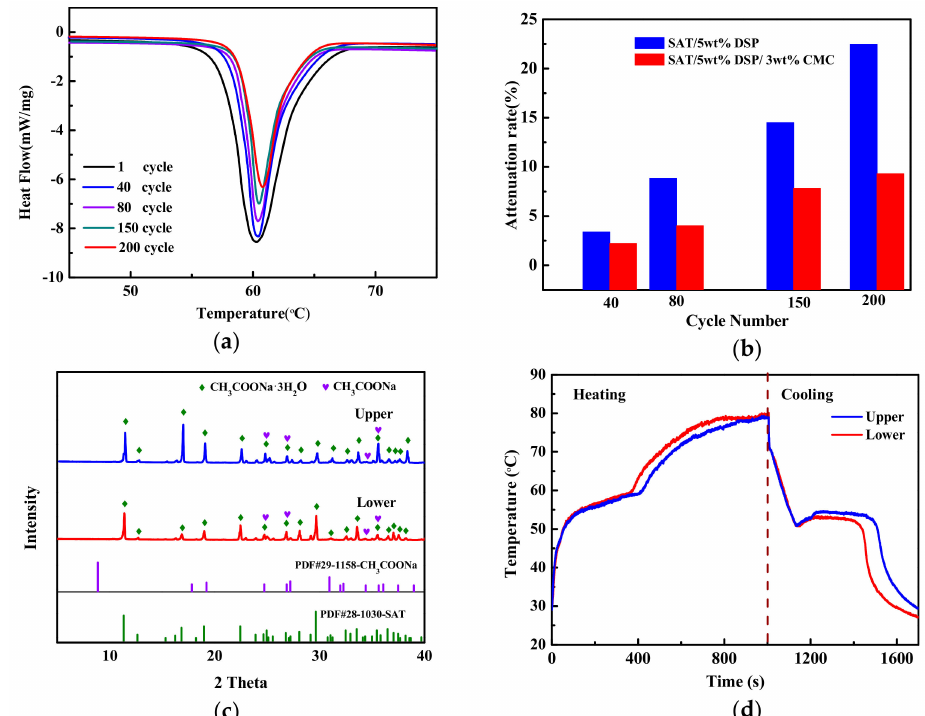
Figure 7. ( a ) DSC melting curves of SAT / 5 wt.% DSP / 3 wt.% CMC and ( b ) the extent of latent heat reduction of SAT / 5 wt.% DSP and SAT / 5 wt.% DSP / 3 wt.% CMC at di ff erent cycles; ( c ) XRD patterns and ( d ) temperature–time curves of upper and lower samples of SAT / 5 wt.% DSP / 3 wt.% CMC.